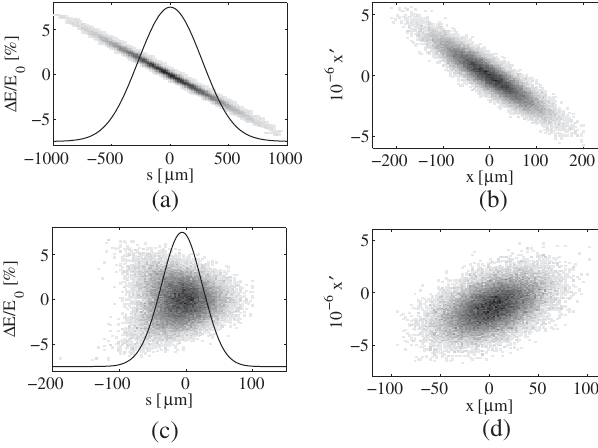
FIG. 7. On the left side plots of initial (a) and final (c) longitudinal phase space distributions and the corresponding charge profiles (a.u.) are shown. On the right side plots of initial (b) and final (d) horizontal phase space distributions are